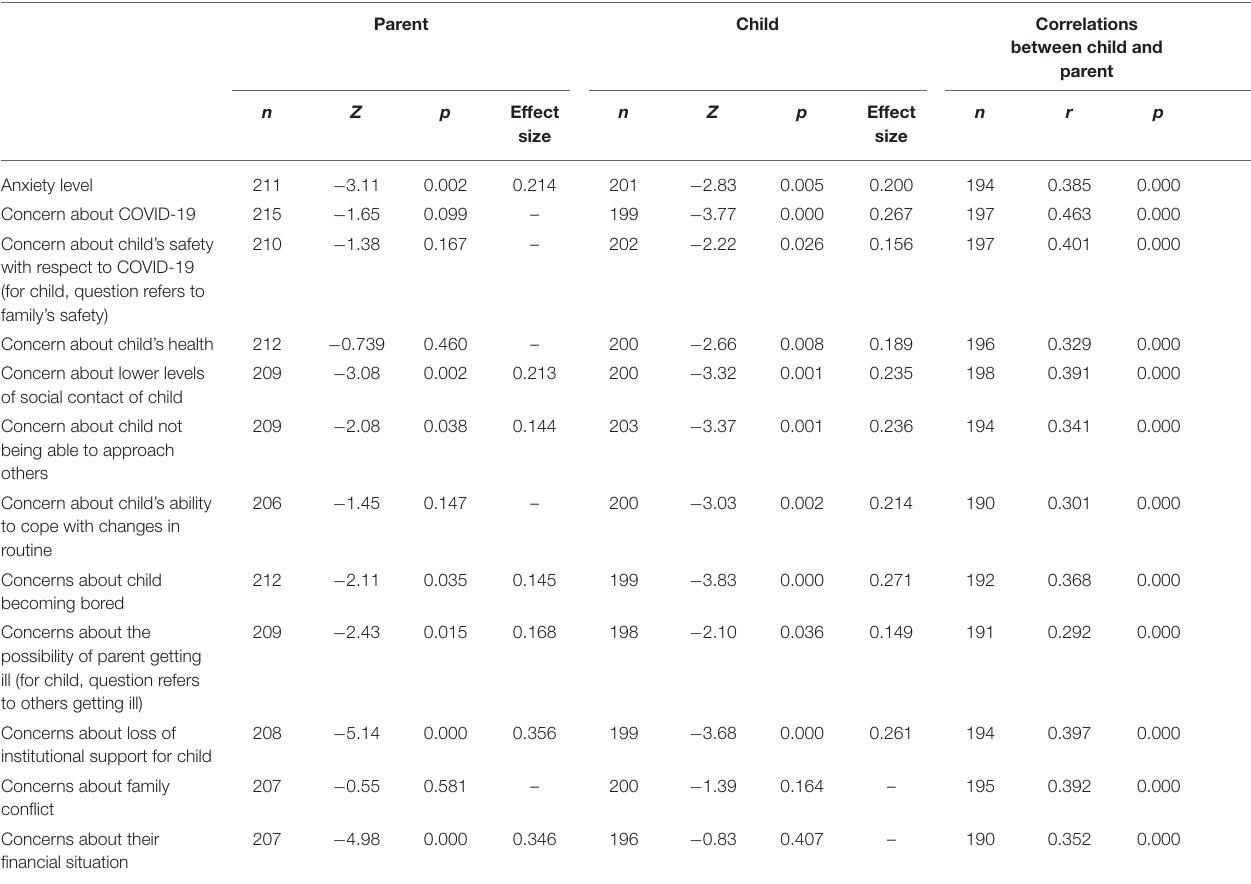
between child and parent